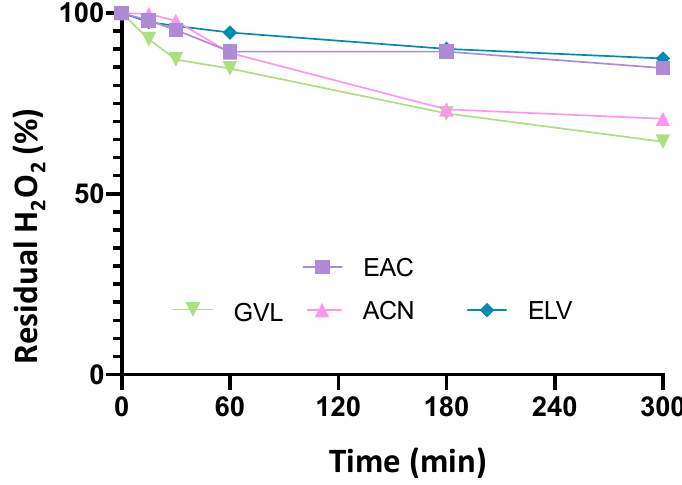
Figure 4. Residual hydrogen peroxide values for decomposition runs in the presence of different solvents. Experimental conditions: 600 mg of catalyst, 6.9 g of H 2 O 2 (60% wt.), 20 cm 3 of solvent, and reaction temperature of 78–80 °C.